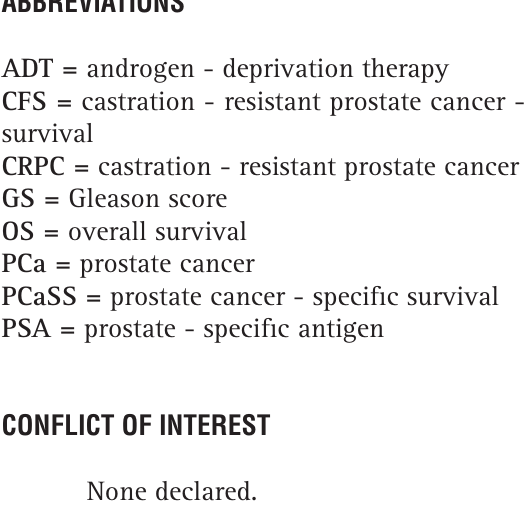
Previous studies suggested a role for initial PSA level as a prognostic marker when the PSA level is < 20 ng / mL and ≥ 100 ng / mL. This study revealed the relationship between PSA level and prognosis when the PSA level is between 20 and 100 ng /